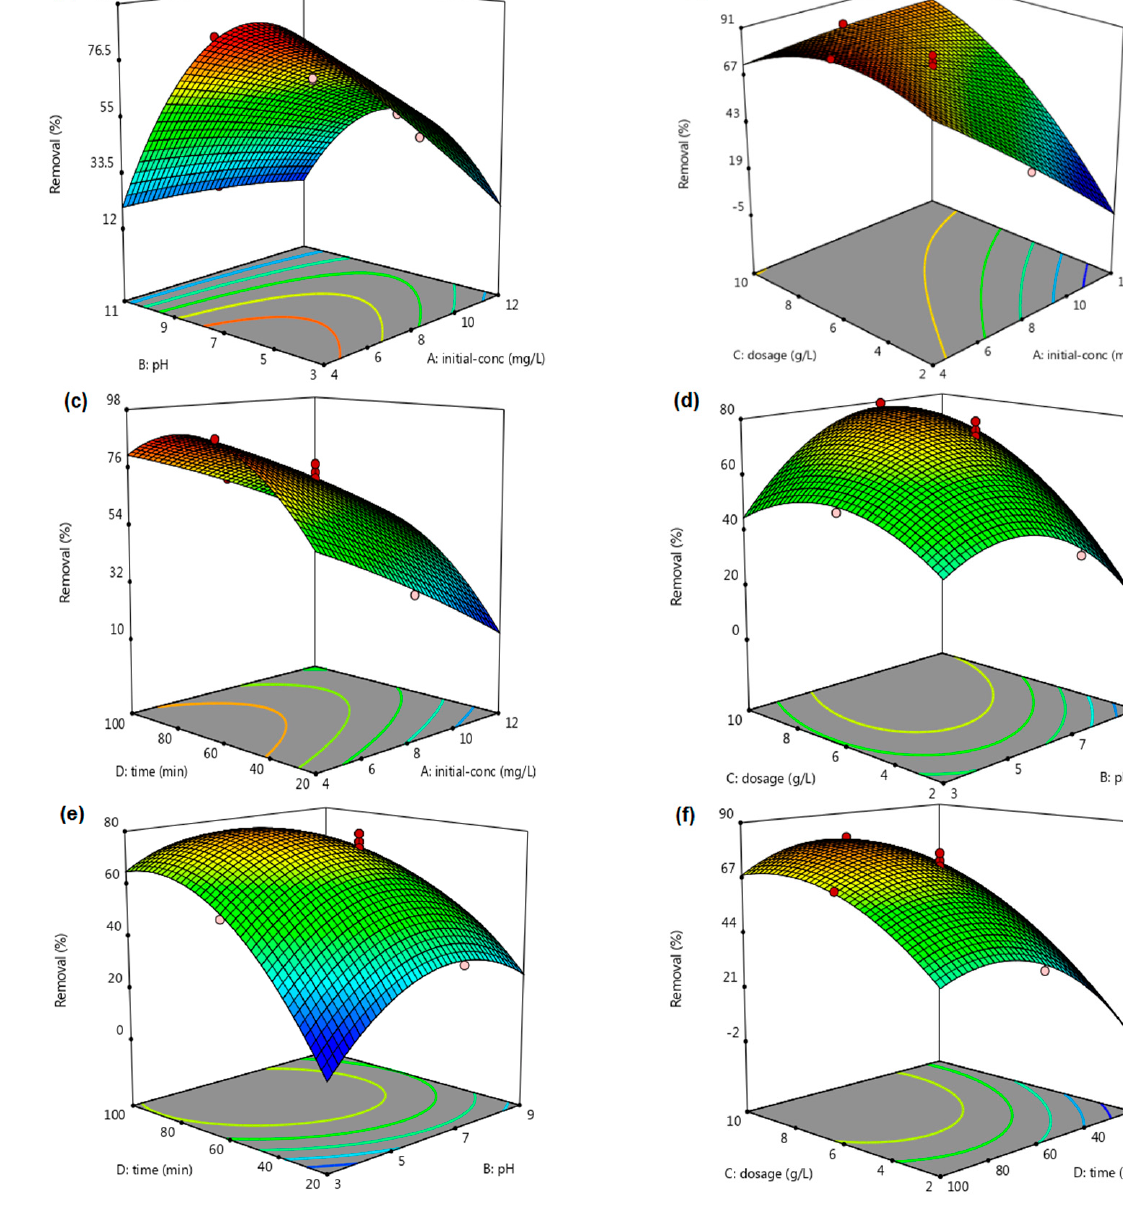
Figure 7. 3D plots of fluoride adsorption by the PG adsorbent showing the interaction effect of ( a ) F − concentration and pH, ( b ) F − concentration and dosage, ( c ) F − concentration and time, ( d ) pH and dosage, ( e ) pH and time, and ( f ) time and dosage.